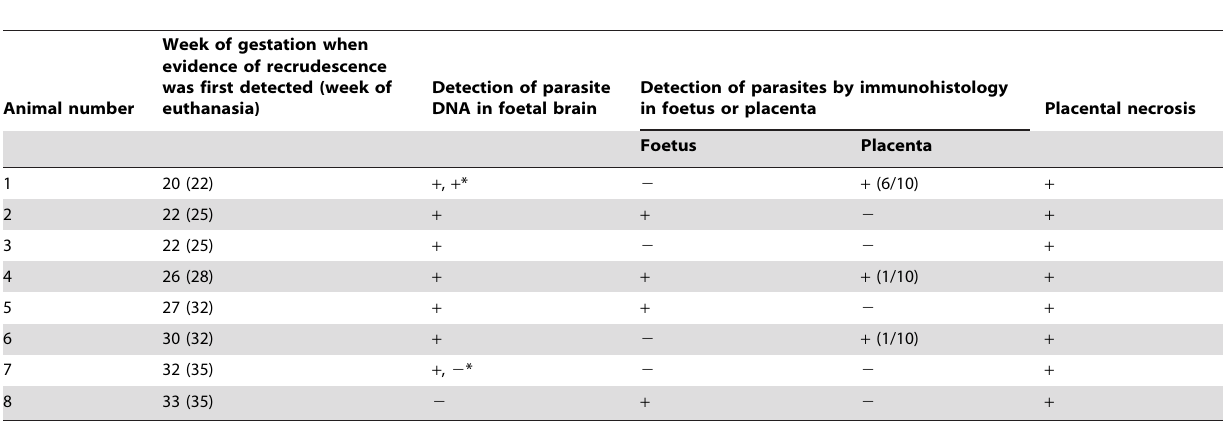
Table 1. Evidence that N. caninum infection was present in the foetuses and placentae of all eight cows following parasite